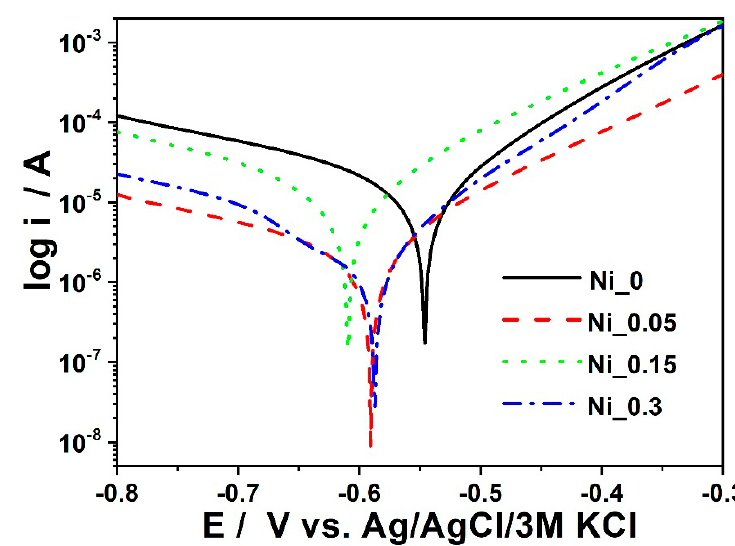
Figure 8. Polarization curves for samples Ni_0 to Ni_0.3.